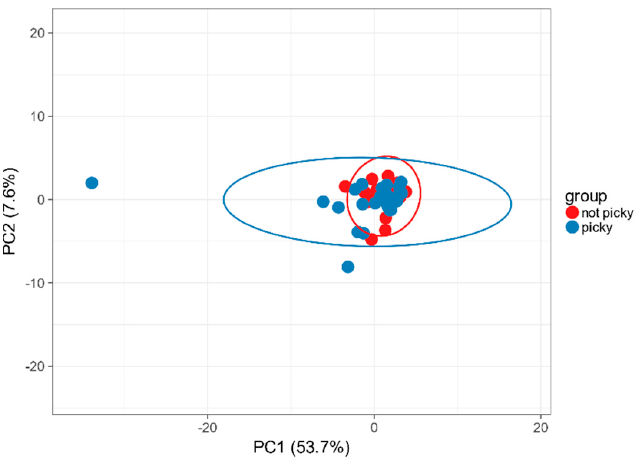
Figure 3. Diversity of intestinal microbiota at the phylum level in “picky eaters” compared to “non-picky eaters”. ClustVis PCA.